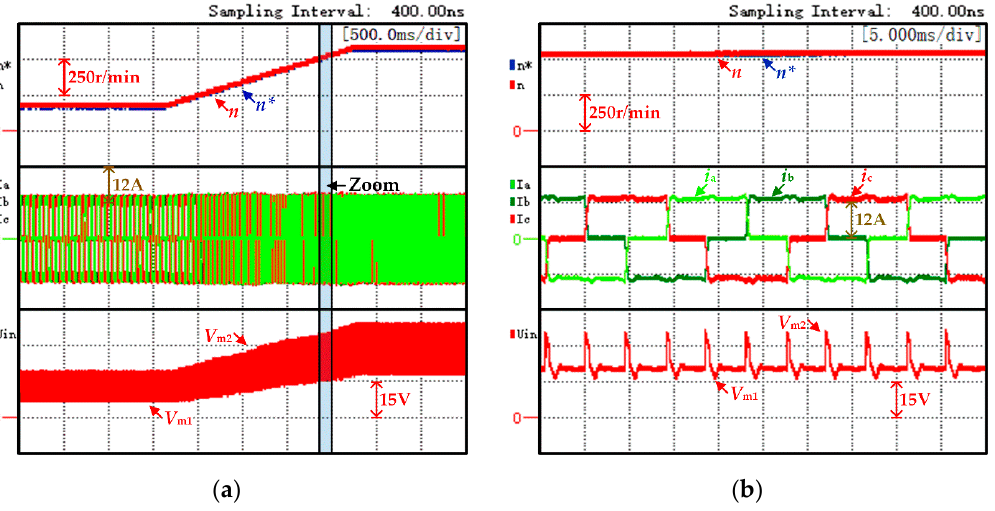
Figure 14. Dynamic response of speed variation in the proposed strategy ( T L = 3.2 N · m): ( a ) overall view; and ( b ) enlarged view.